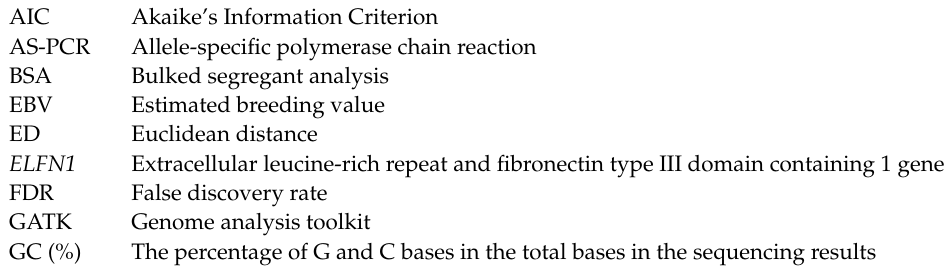
marketing weight, Table S2: Primer pairs of the candidate genes used for quantitative real-time PCR, Figure S1: The allele frequincies of the first population for males of LEBV (first row), males of HEBV (second row), females of LEBV (third row), and females of HEBV groups (forth row), Figure S2: Allelic and genotypic frequencies for males of both populations, whereas (first row) allelic frequency and (second row) genotypic frequency of P1 and (third row) allelic frequency and (forth row) genotypic frequency of